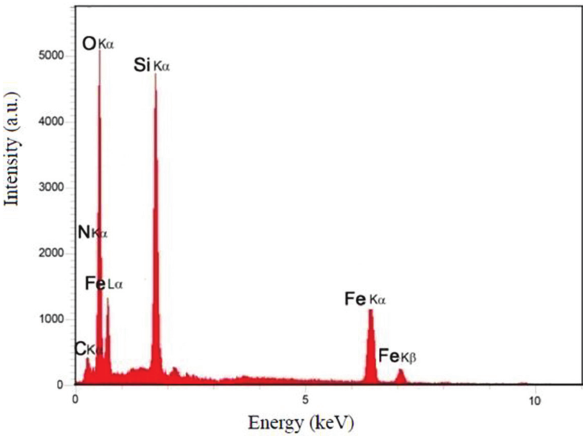
Figure 6: EDS spectrum of Fe